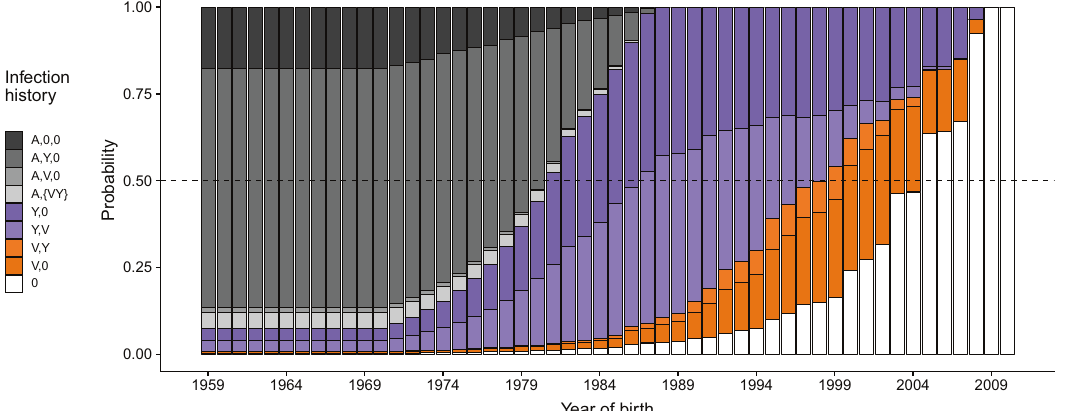
Fig. 4 Probabilities of different infection histories with in fl uenza B in New Zealand for people born between 1959 and 2010, and observed in 2010. Infection histories consist of the lineage of fi rst infection and lineages encountered later regardless of their order. Probabilities were estimated by fi tting the model to case data from New Zealand. ( A ,0,0): fi rst infection before 1988 and no subsequent infections with either B/Victoria or B/Yamagata. ( A , Y ,0) and ( A , V ,0): fi rst infection before 1988 followed by B/Yamagata but not B/Victoria and by B/Victoria but not B/Yamagata, respectively. ( A ,{ V , Y }): fi rst infection before 1988 followed by infections with both B/Victoria and B/Yamagata in any order. ( Y , V ) and ( Y ,0): fi rst infection with B/Yamagata, with and without a subsequent B/Victoria infection. ( V , Y ) and ( V ,0): fi rst infection with B/Victoria, with and without a subsequent B/Yamagata infection. (0): fully naive to in fl uenza